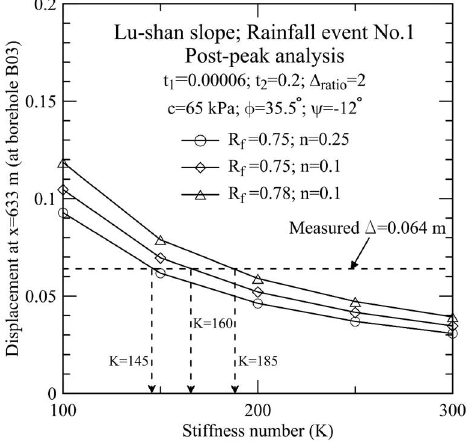
Figure 21. Results of back-analyses for displacement-related parameter K obtained using various values of R f and n as well as considering post-peak softening behavior.